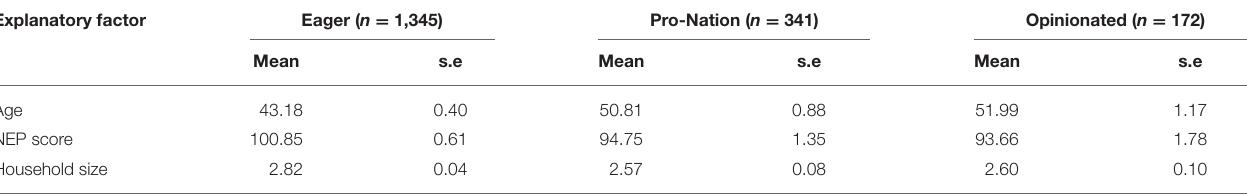
TABLE 7 | Numeric explanatory factors that describe the three latent classes of the main urban resident’s sample ( n = 1,859). Explanatory